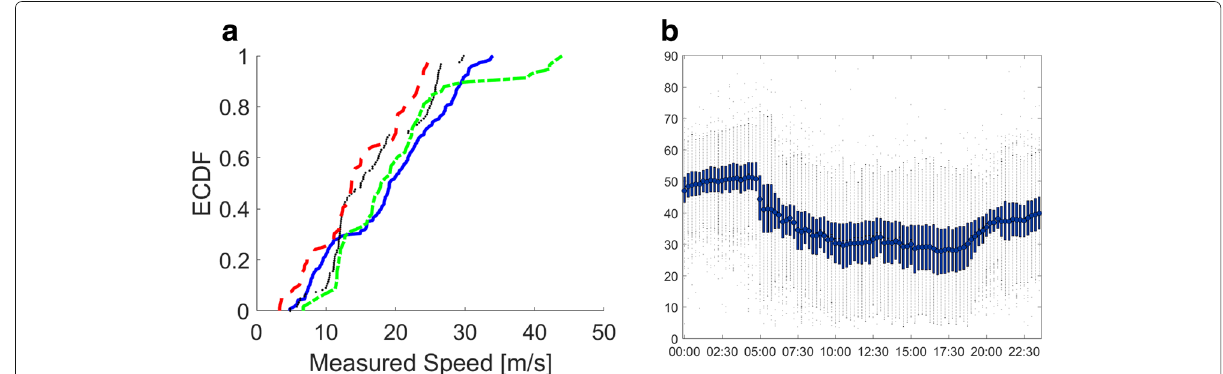
Fig. 3 a ECDF of average speed for all links (in m/s). Hietzing (blue), Westbahnhof (black, dotted), Ring (red, dashed), Südosttangente (green, dash-dotted). b Typical grouped (over intervals) plot of link speed measurements in km/h (including confidence intervals) for one link in